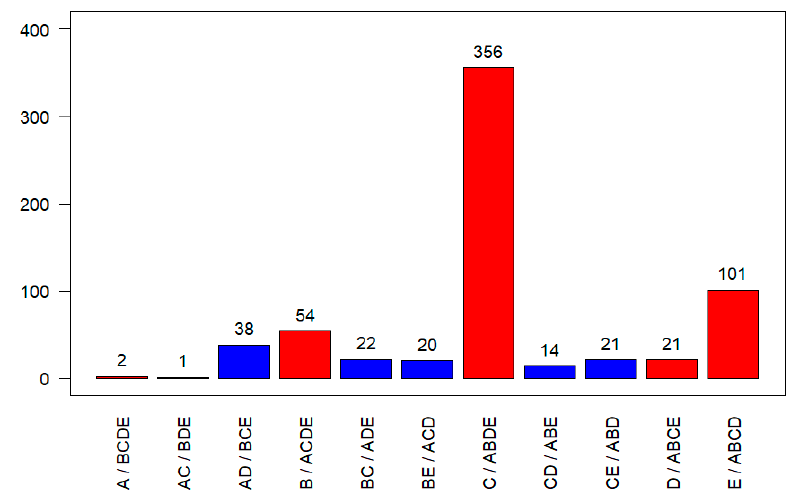
Figure 2. Number of genome positions in the CpGV whole genome alignment consensus sequence that encode for alleles with single nucleotide polymorphisms (SNPs) either specific for single genome groups (red columns) or two genome groups (blue columns). No common SNPs were detected for the combined genome groups AB, BD, or AE. The corresponding alleles are listed after the slashes.